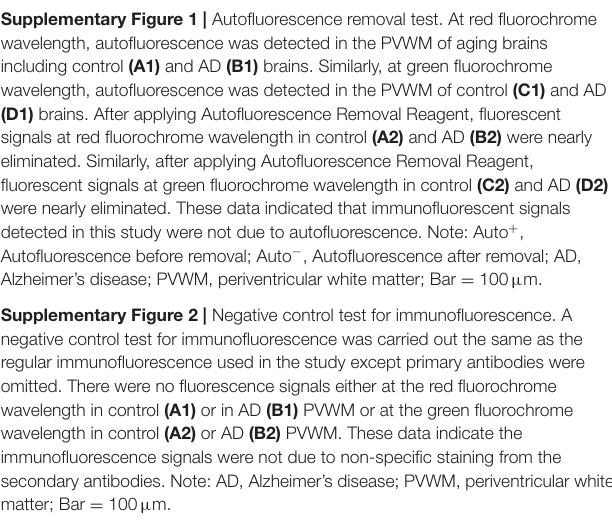
Supplementary Figure 3 | Immunofluorescence of GFAP and its negative control. Immunofluorescence of GFAP was detected in control PVWM (A1) and AD PVWM (B1) . In controls, GFAP positively stained astrocytes as well as the vesicle ( A1 , arrow). In AD PVWM (B1) , GFAP positively stained astrocytes and vesicles ( B1 , arrows) as well. Negative controls with deletion of primary GFAP antibody showed no signals in both control (A2) and AD (B2) brains. Note: AD, Alzheimer’s disease; PVWM, periventricular white matter; Bar = 50 µ